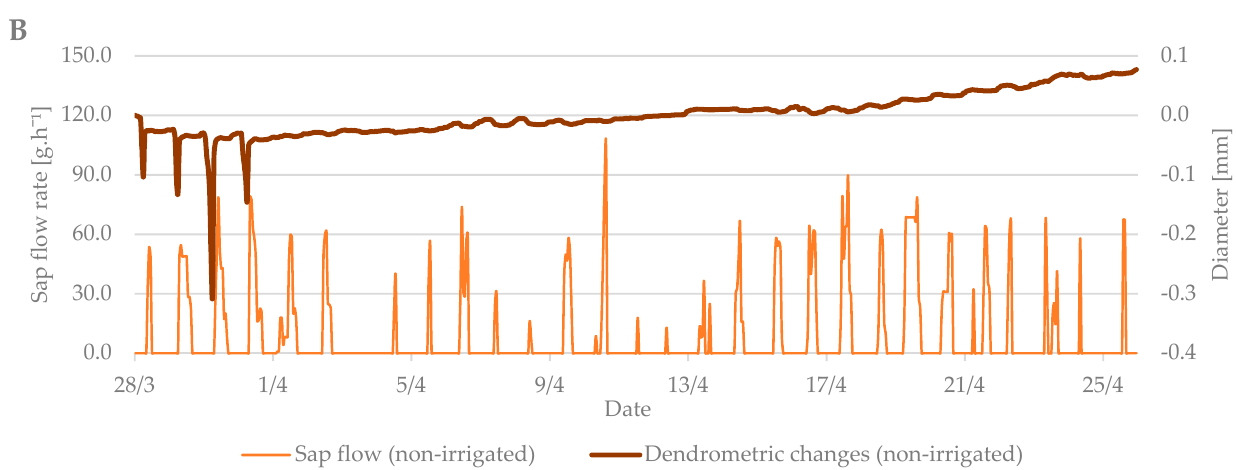
Figure 5. The shrinkage of branch diameter of irrigated ( A ) and non-irrigated ( B ) trees during the budbreak period in 2019 in comparison to sap flow rate.